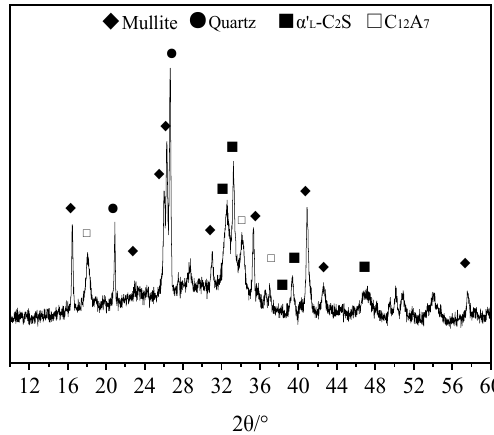
Figure 1. X-ray di ff raction of belite cement